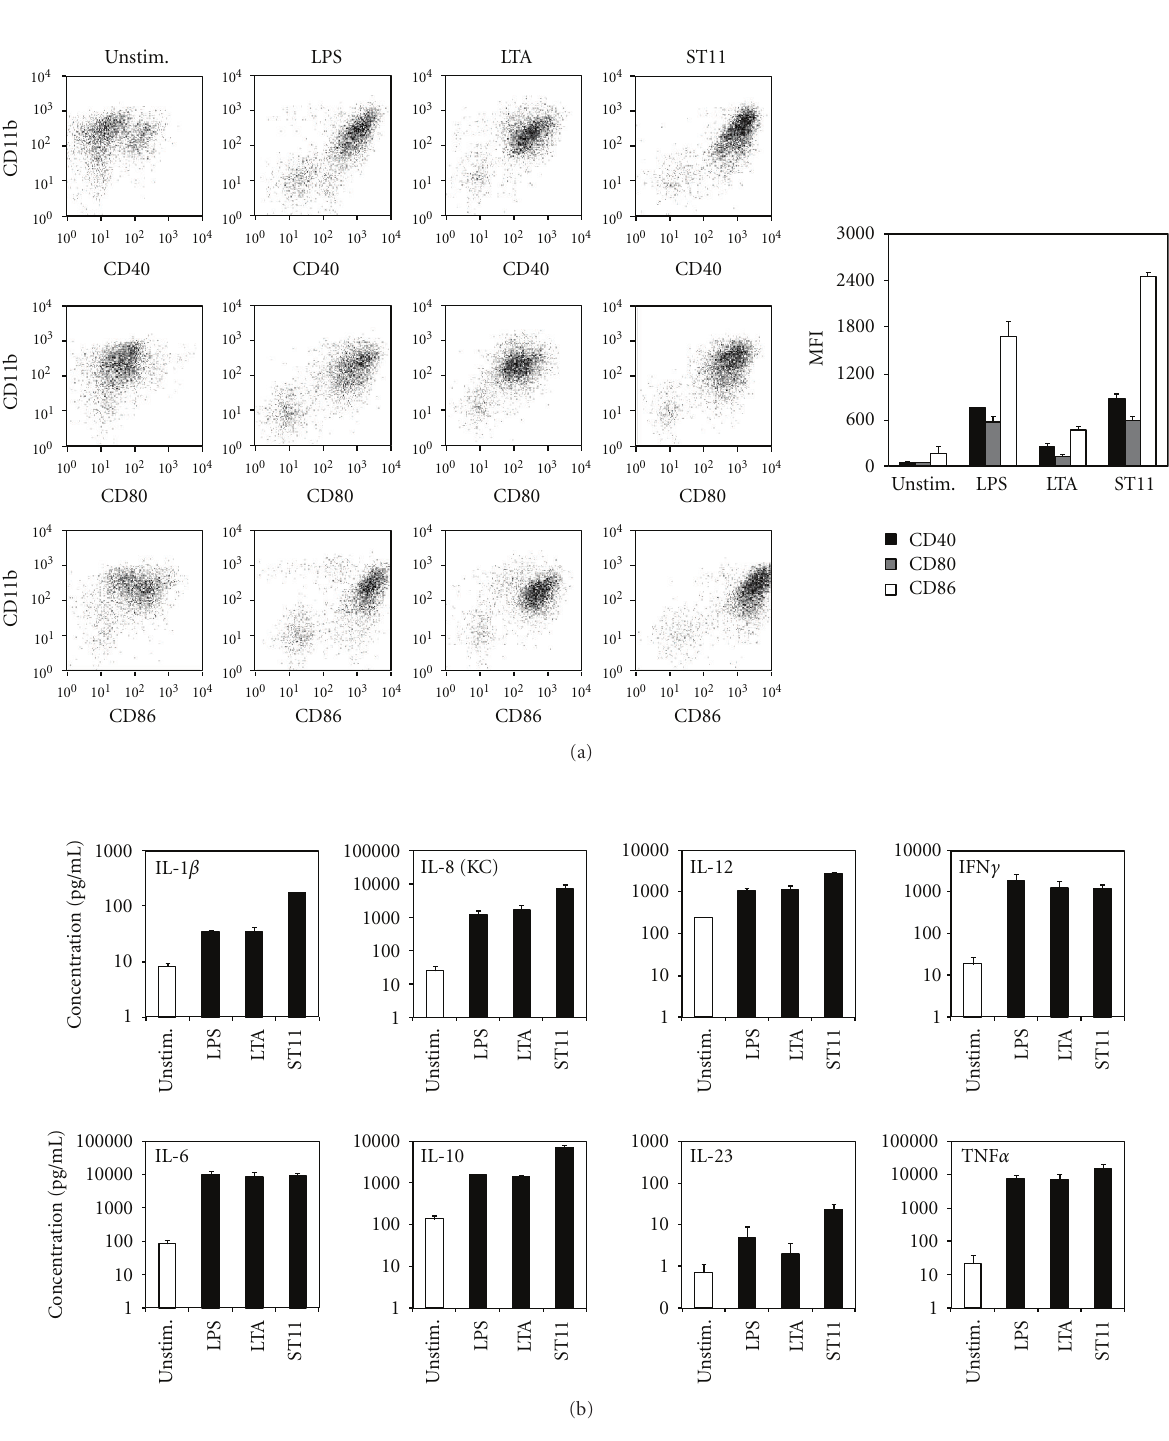
Figure 1: ST11 induces phenotypic DC maturation and specific cytokine release pattern. (a) 5 × 10 5 BM-DCs were cultured for 24h in the absence (Unstim.) or the presence of ST11 (at bacteria:DC ratio of 100 :1). As positive control LPS or LTA stimulations were used at 1 μ g/mL. CD40, CD80, and CD86 expressions were determined by flow cytometry. Representative dot plots are shown in the left panel, and mean fluorescent intensity values ± SD for three separate experiments are shown in the right bar graph. (b) 5 × 10 5 BM-DCs were cultured for 24h in the absence (Unstim.) or the presence of ST11 (at bacteria:DC ratio of 100 :1), LPS (0.1 μ g/mL), or LTA (1 μ g/mL), then supernatants were analyzed by multiplex ELISA. Results are mean values ± SD obtained in three independent cultures and expressed in pg/mL of supernatants for each